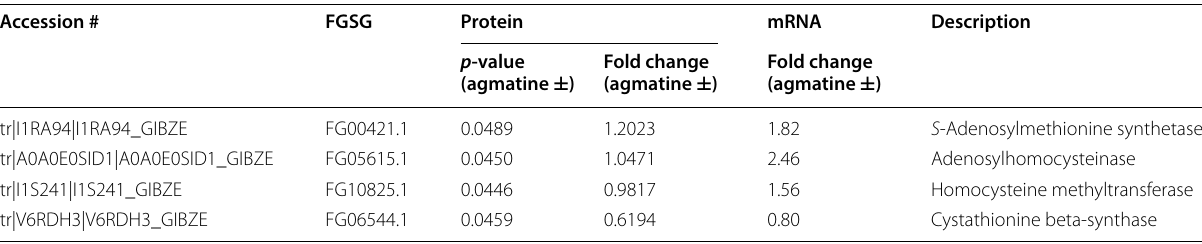
Protein peptides were detected using LC–MS/MS as described in the “Materials and methods” section. Accession # is the number in UniProt. Data marked with an asterisk (*) are quoted from Suzuki et al. (2013)